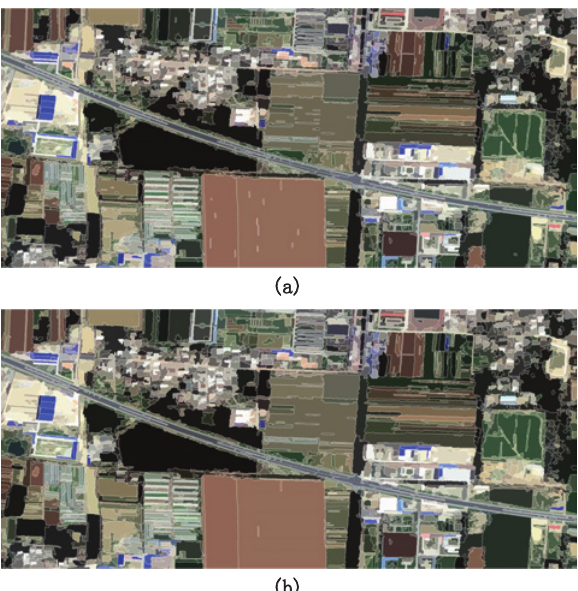
Figure 4. (a)Meanshift filter result (b)Meanshift image segmen- tation